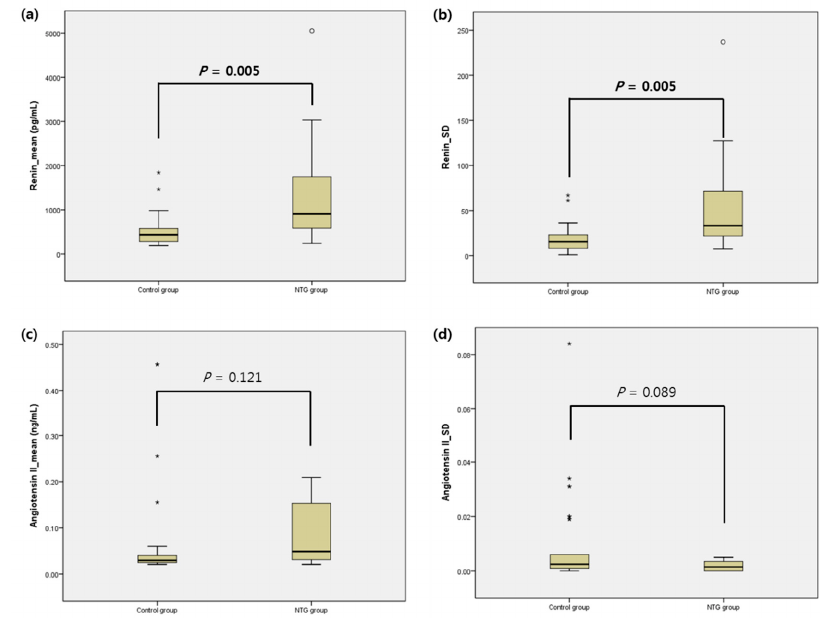
Table 3. Results of the enzyme-linked immunosorbent assay (ELISA) of renin and angiotensin II in the control group and the normal tension glaucoma (NTG) group. lipoprotein; hs-CRP: high-sensitivity C-reactive protein. Significant values are shown in bold. The mean concentration and SD of renin and AngII from each group are reported in Table 3 and Figure 1. The mean concentration and SD of renin were higher in the NTG group (mean: 528.06 ± 341.54 vs. 1355.64 ± 1279.52, p = 0.005; SD: 17.79 ± 14.29 vs. 49.45 ± 49.41, p = 0.005). The mean concentration and SD of AngII were higher in the NTG group but not statistically significant ( p = 0.121 and 0.089, respectively). According to Figure 1, the range of distribution of renin was wider in the NTG group.